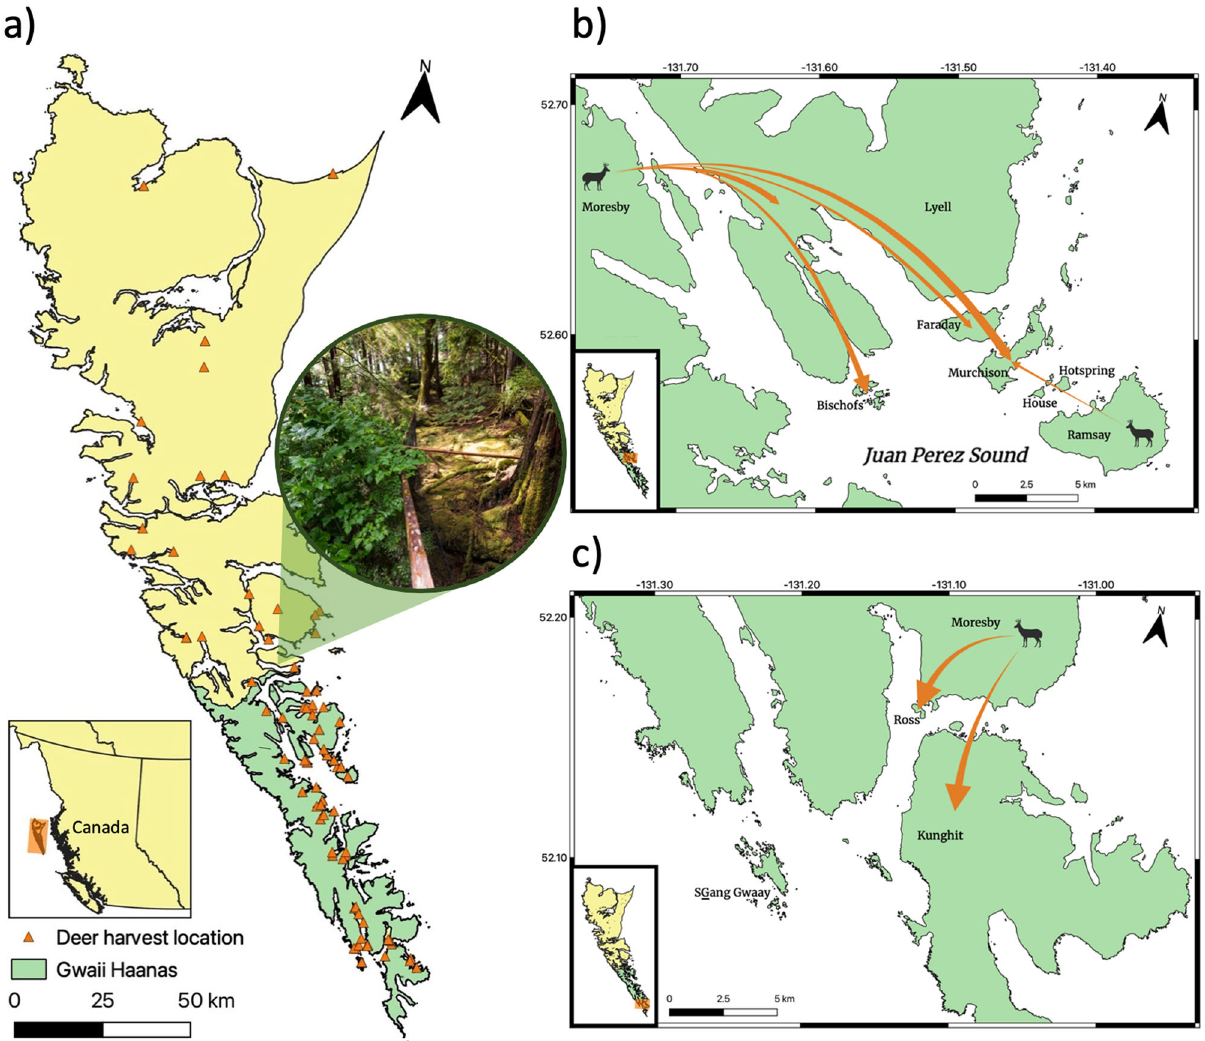
Fig. 1 Sampling distribution of Sitka black-tailed deer in Haida Gwaii and directional migration within Gwaii Haanas. Haida Gwaii is a densely forested archipelago ~60 – 100 km off the western coast of Canada and is threatened by invasive Sitka black-tailed deer. a Deer were harvested across the archipelago, including Gwaii Haanas (green), and harvest locations representing the 181 individuals genotyped for this study are shown (orange triangles). The image (© Parks Canada) depicts a deer exclosure established on Kunga Island. b Contemporary migration of deer into northern Juan Perez Sound from Moresby Island, as well as the weaker signal of migration coming from Ramsay Island. Arrow width is relative to directional migration rates, estimated as the number of migrants per generation. c Contemporary migration of deer to Ross and Kunghit Islands in the south of Gwaii Haanas. Note that the two other instances of signi fi cant migration indicated in the text and Supplementary Table 5 are outside of Gwaii Haanas and are not depicted here. Locator maps are set in the bottom left of each panel, with the enlarged areas highlighted in